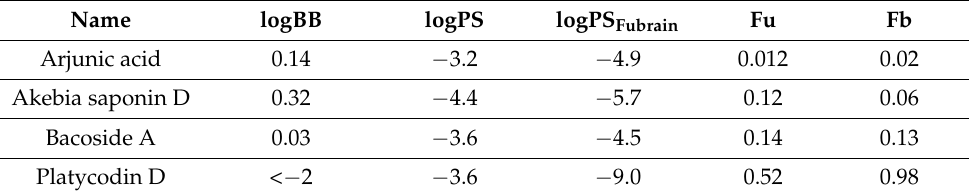
Table 3. The pharmacokinetic BBB descriptors calculated in silico